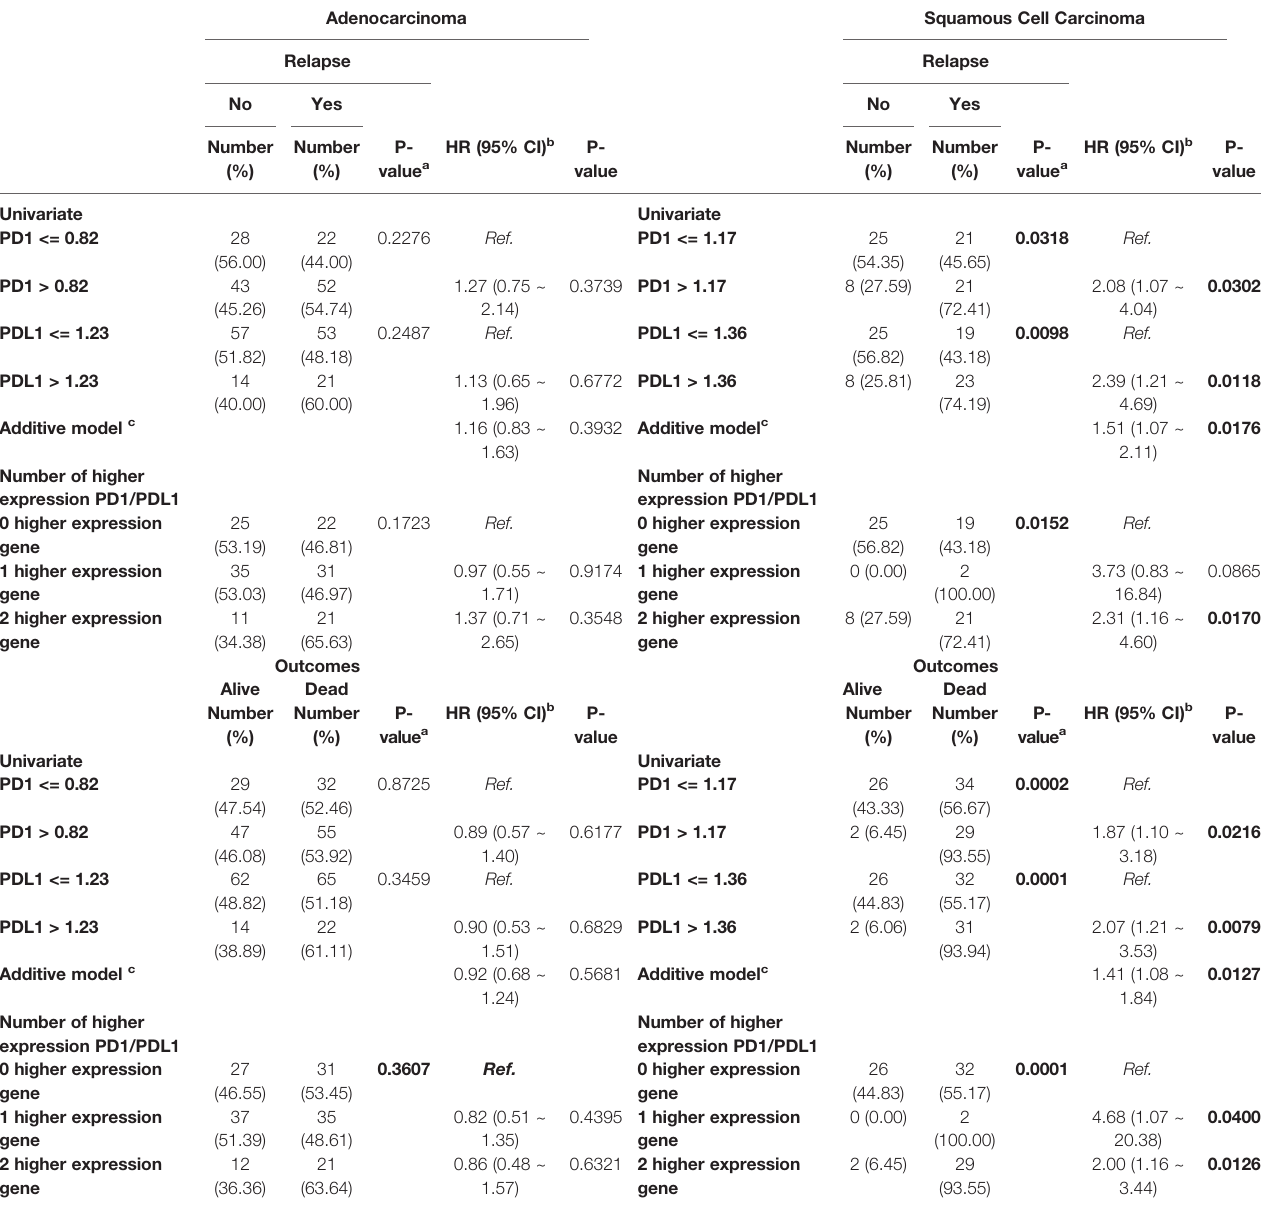
TABLE 3 | Cox regression analyses of PD1 and PDL1 gene expression levels at late stage lung cancer